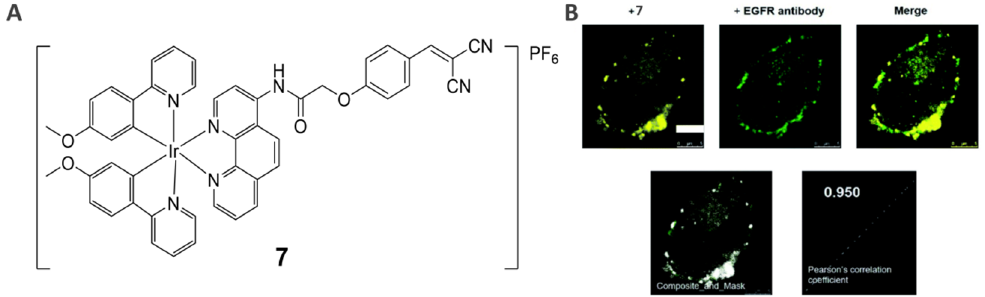
Figure 6. ( A ) Chemical structures of complex 7 . ( B ) Co-localization studies of complex 7 (1 μM, 30 min) with immunofluorescence imaging in A431 cells (λ exc /λ emi = 405 nm/500−700 nm). Reproduced with immunofluorescence imaging in A431 cells ( λ exc / λ emi = 405 nm/500 − 700 nm). Reproduced with permission from ref. [57]. Copyright 2020 American Chemical Society. with permission from ref. [57]. Copyright 2020 American Chemical